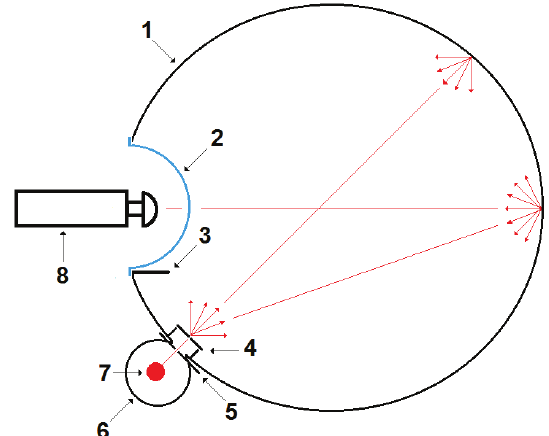
Figure 2. Sketch of modification to the 1m diameter integrating sphere: (1) Labsphere CSTM-LR-40, (2) transparent Lexan dome, (3) baffle, (4) transparent diffusor, (5) adjustable aperture, (6) source sphere, (7) tungsten lamp, and (8) instrument with all-sky lens. Red arrows and lines indicate the effect of multiple scattering inside the sphere.